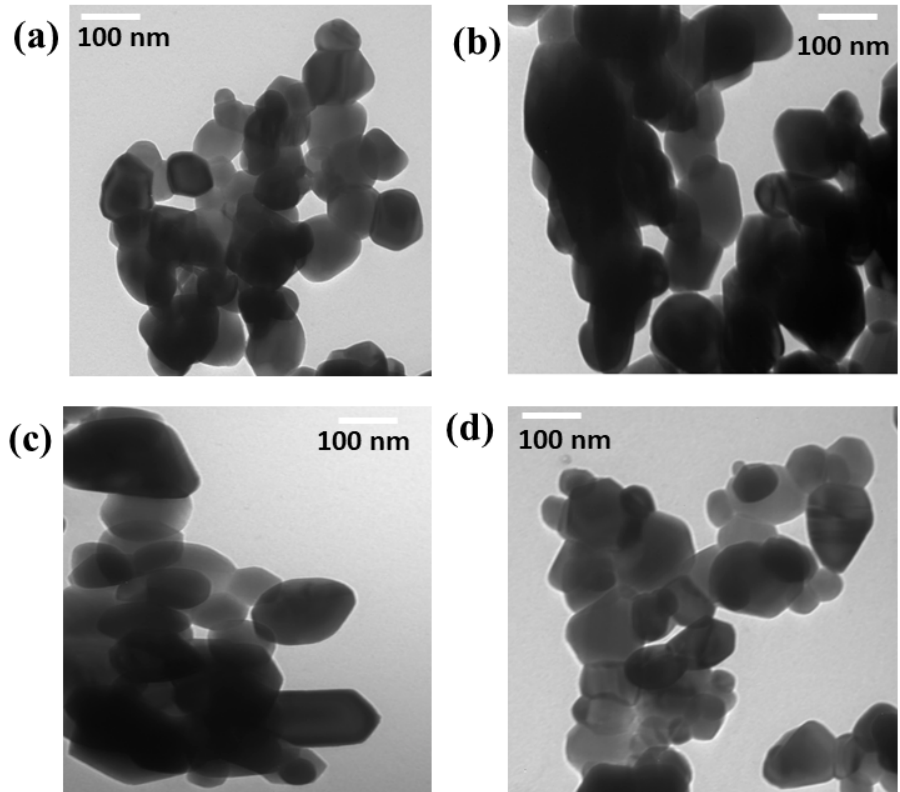
Figure 3. TEM photos of ( a ) pure ZnO, ( b ) 3% Fe doped ZnO, ( c ) 5% Fe doped ZnO, ( d ) 15% Fe doped ZnO. doped